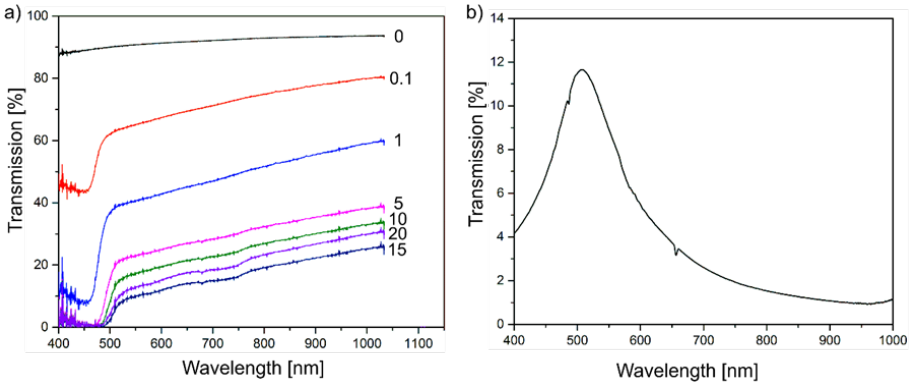
Figure 5. UV-Vis Transmission spectra of ( a ) (Cd:Zn)S/P(VDF-TrFE) composite films (0 = 0 vol %, 0.1 = 0.1 vol %, 1 = 1 vol %, 5 = 5 vol %, 10 = 10 vol %, 15 = 15 vol %, 20 = 20 vol %) without gold electrodes and ( b ) the single gold electrode with a thickness of 30 nm.